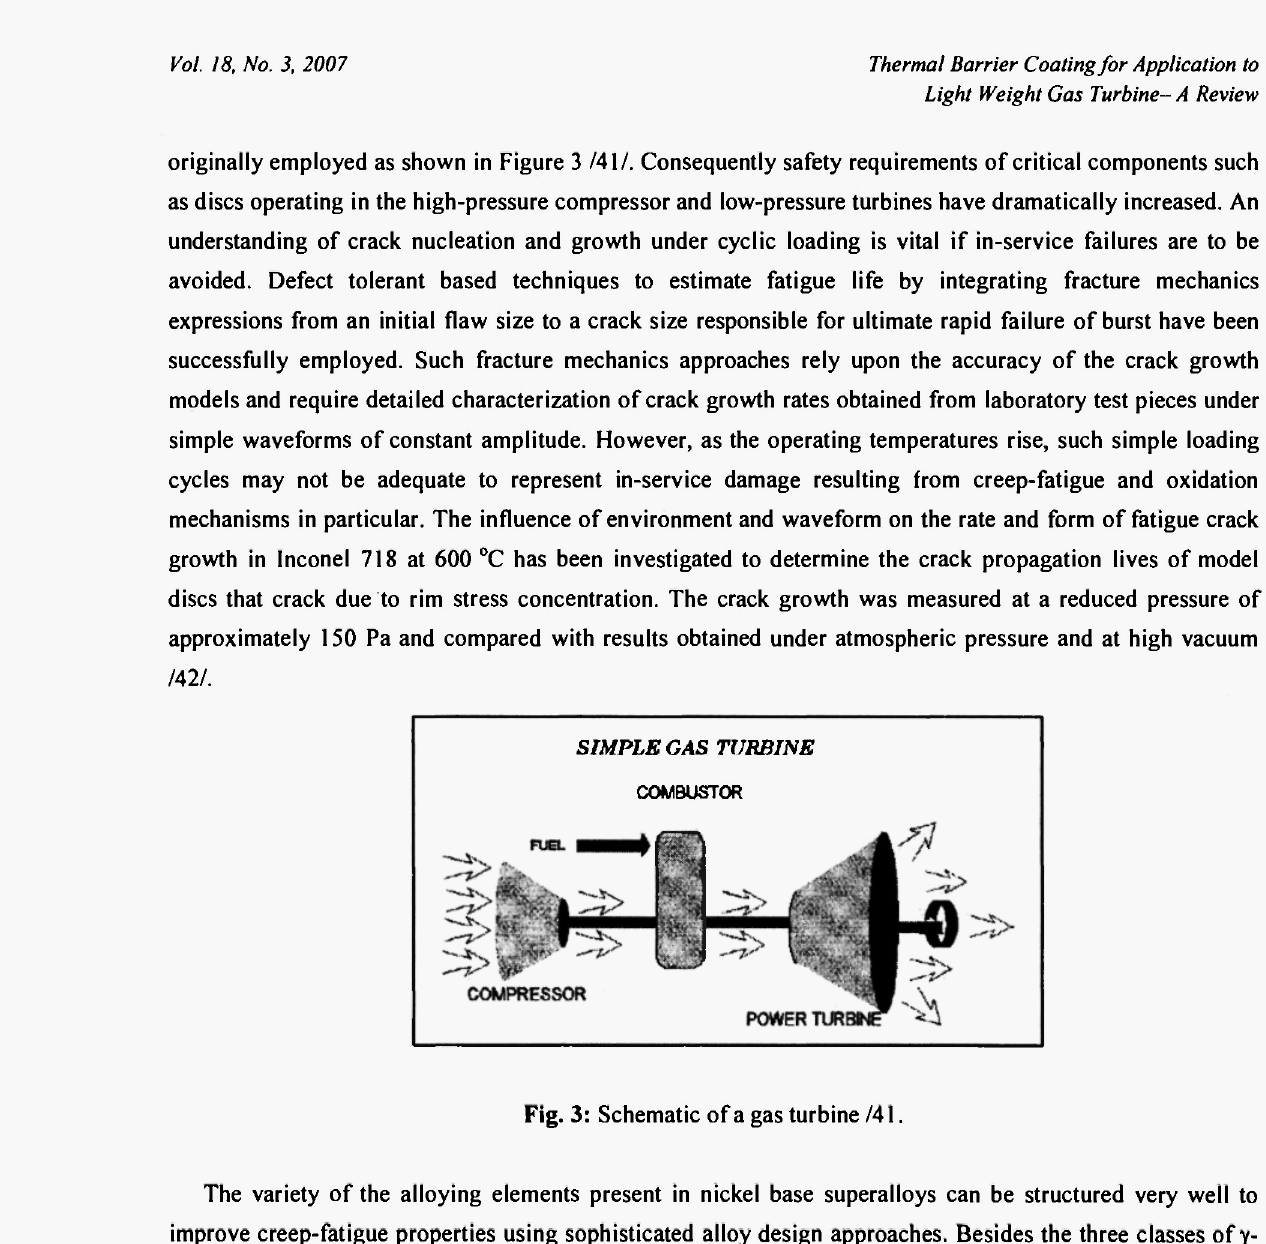
Fig. 3: Schematic of a gas turbine